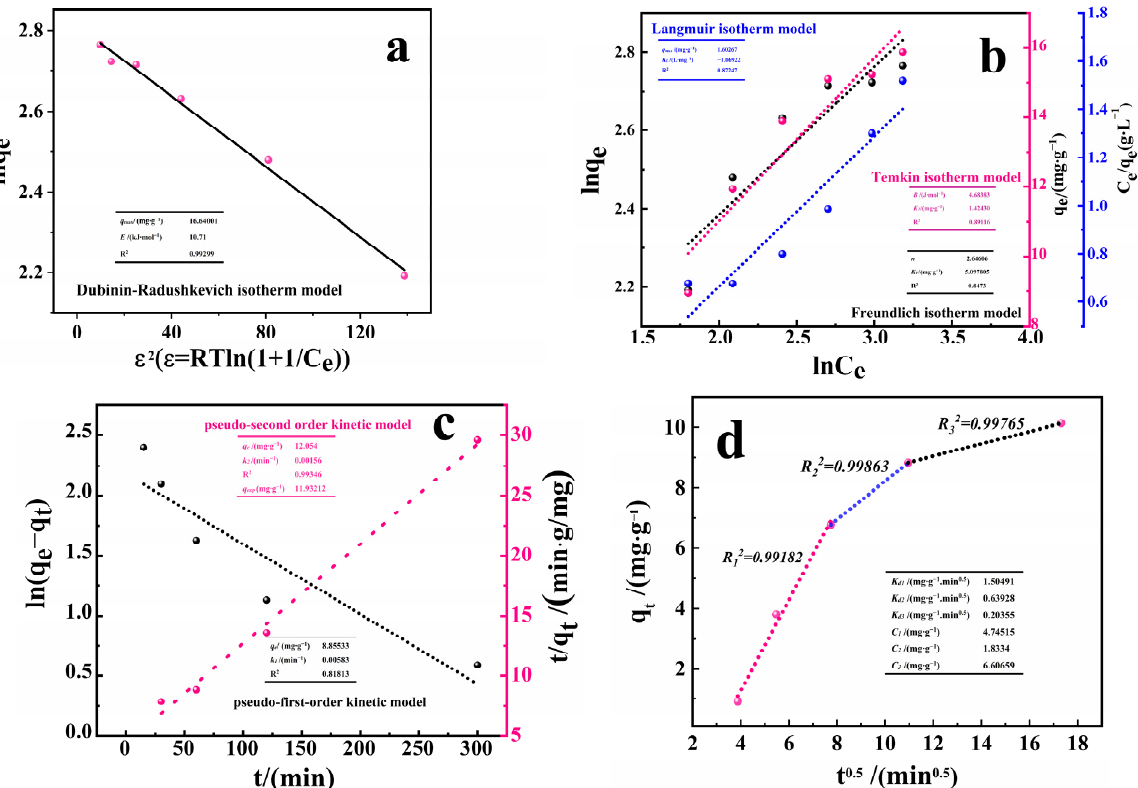
Figure 7. ( a , b ) Fitting of adsorption isotherms of PACMC. ( c ) Kinetics of RhB uptake on PACMC. ( d ) Particle diffusion model for RhB adsorption by RhB ( C 0 = 20 mg·L − 1 , Adsorbent mass: 1 g·L − 1 , Temperature: 20 °C, pH = 6.88, Reaction time: 6 h).